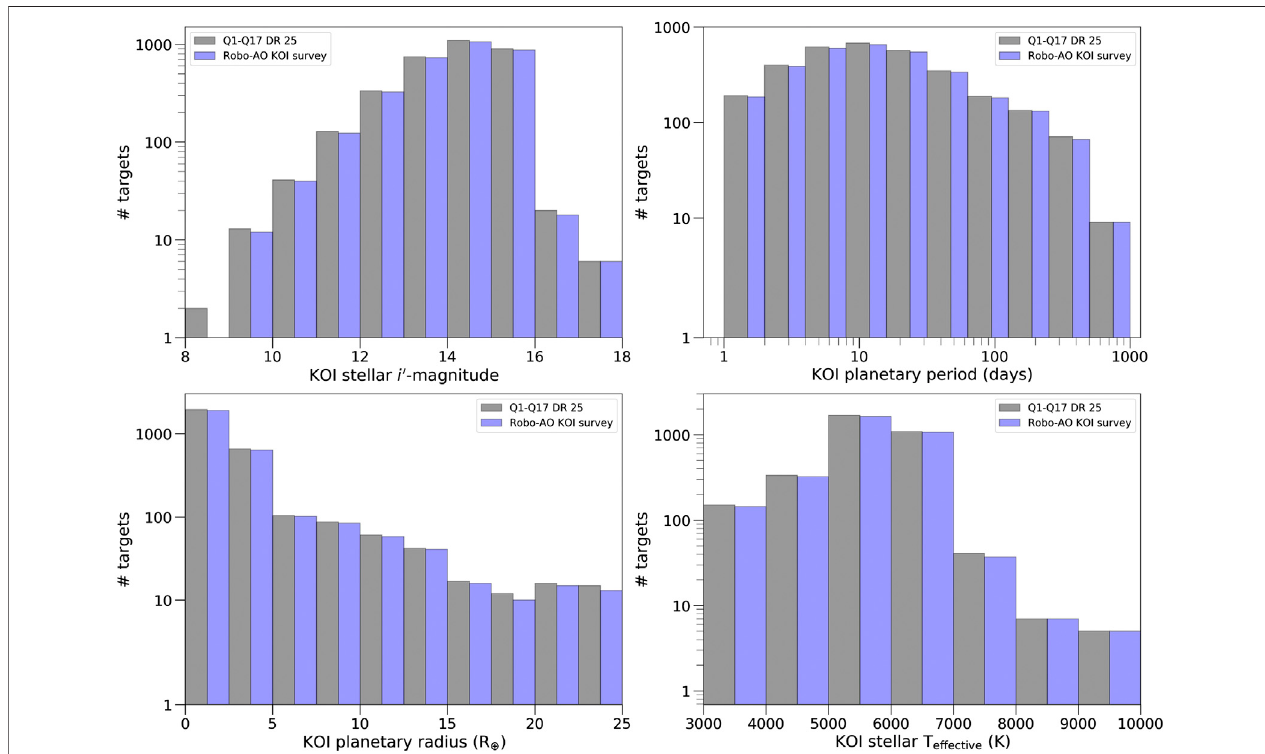
FIGURE1 | The properties ofKOIs observed in the Robo-AO survey are compared to the fullset ofKOIs from Q1 – Q17 (Borucki et al., 2010; Boruckiet al., 2011a; Borucki et al., 2011b; Batalha et al., 2013; Burke et al., 2014; Rowe et al., 2014; Coughlin et al., 2016; Mathur et al., 2017).